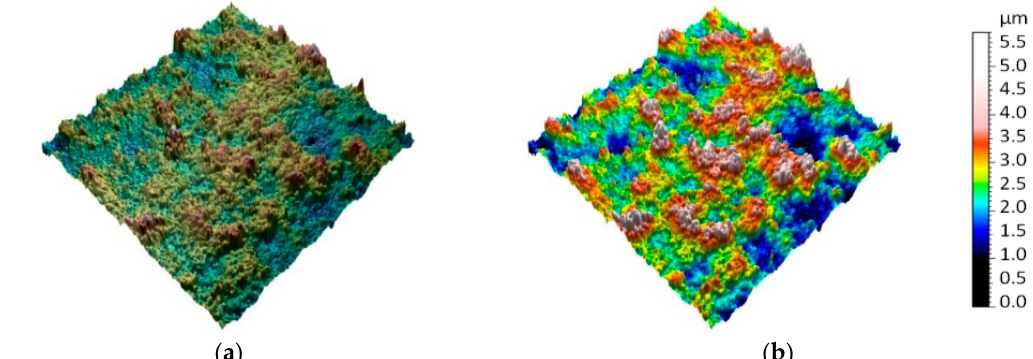
Figure 12. Topographic digital model of a sub-micrometer scale region (100 × 100 µm)— interferometric measurements: ( a ) surface topography with image and ( b ) surface topographic map. Nanometer scale (Figure 7, zone 5) determines and digitizes paint pigments (Figure 13).